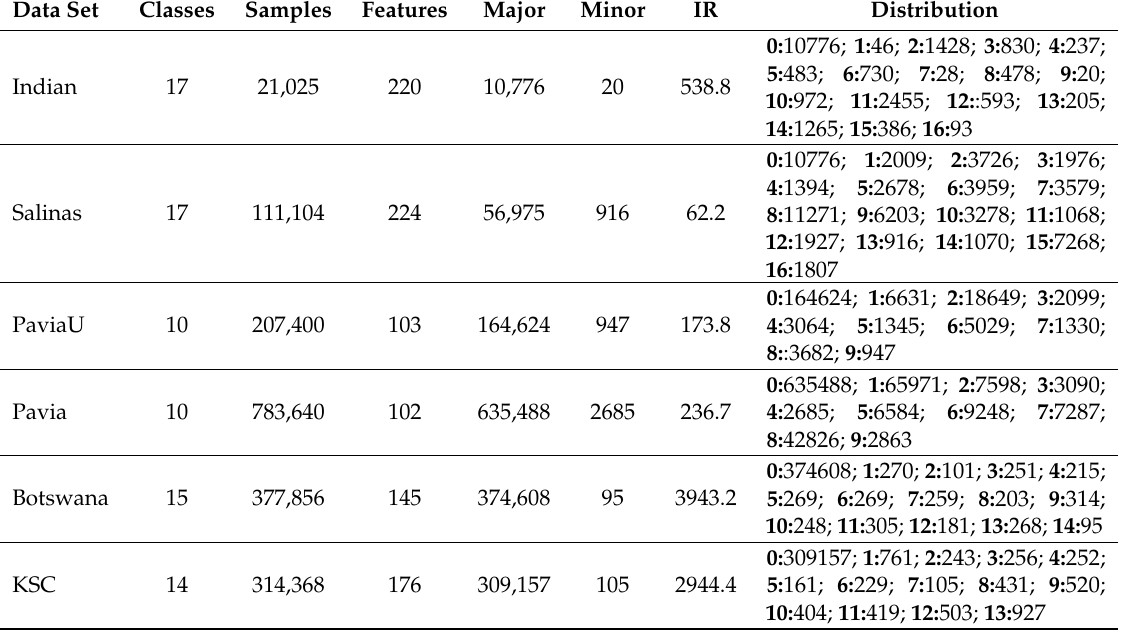
Table 1. Summary of the main database characteristics, such as dataset name, and the numbers of classes, samples and features. Major and Minor correspond to majority and minority classes, respectively. Imbalance ratio IR = Minor/Major, and Distribution is the number of samples by